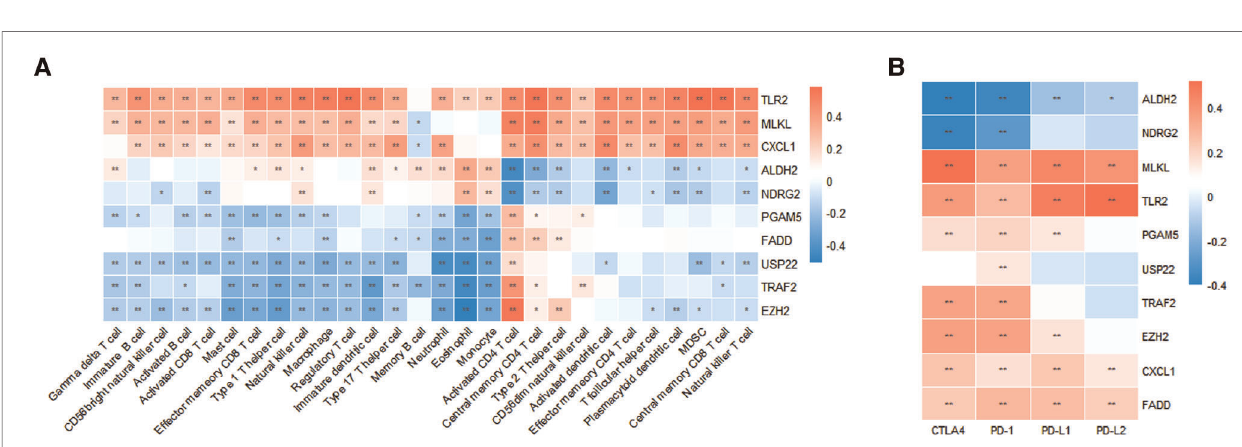
FIGURE 4 | Characterization of TME immune cell in fi ltration. ( A ) Correlation between prognostic necroptosis-related genes and 28 TME-in fi ltrating cell types. ( B ) Relationship between prognostic necroptosis genes and immune checkpoint